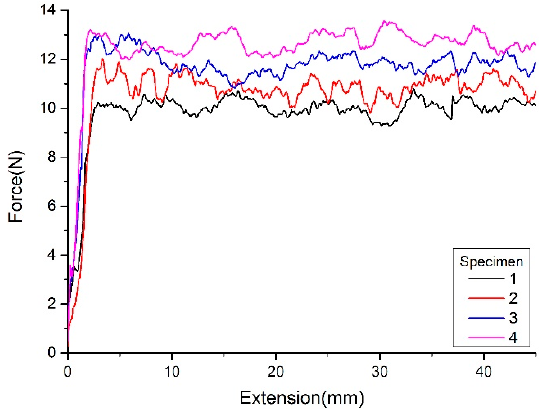
Figure 13. Peeling force with unchanged compaction force.